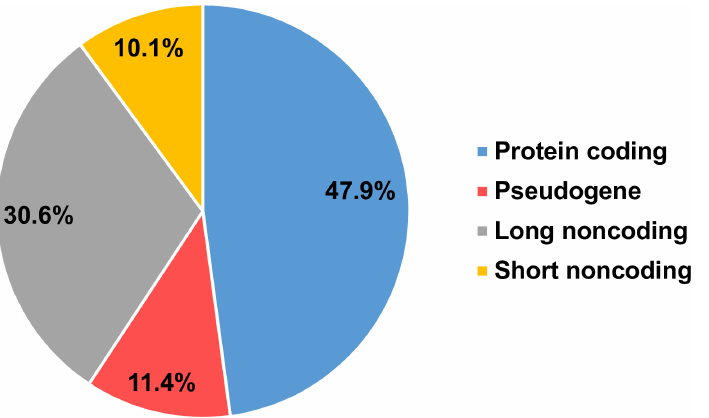
Fig 5. Distribution of differentially methylated promoter regions in ME/CFS according to gene biotype. In RnBeads package, promoters are defined as regions 1500 bp upstream of TSS and 500 bp downstream of TSS. Criteria for DMPs were: FDR (cid:20) 0.1 and mean difference > 0.05. The distribution of these DMPs according to the gene biotype: protein-coding genes and regulatory RNA genes including short non-coding RNAs (miRNAs, small nuclear RNAs,